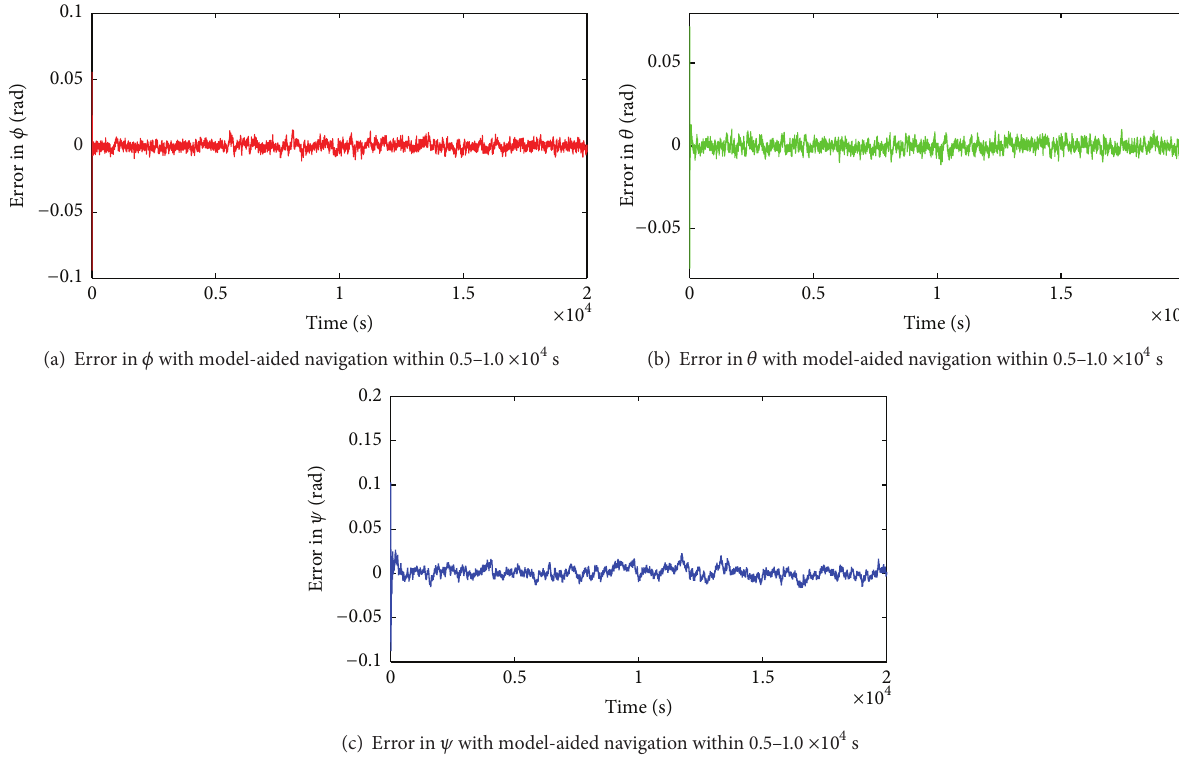
Figure 8: Errors of Euler angles in model-aided navigation within 0.5–1.0 ×10 4 s (A to B) in Figure 6.